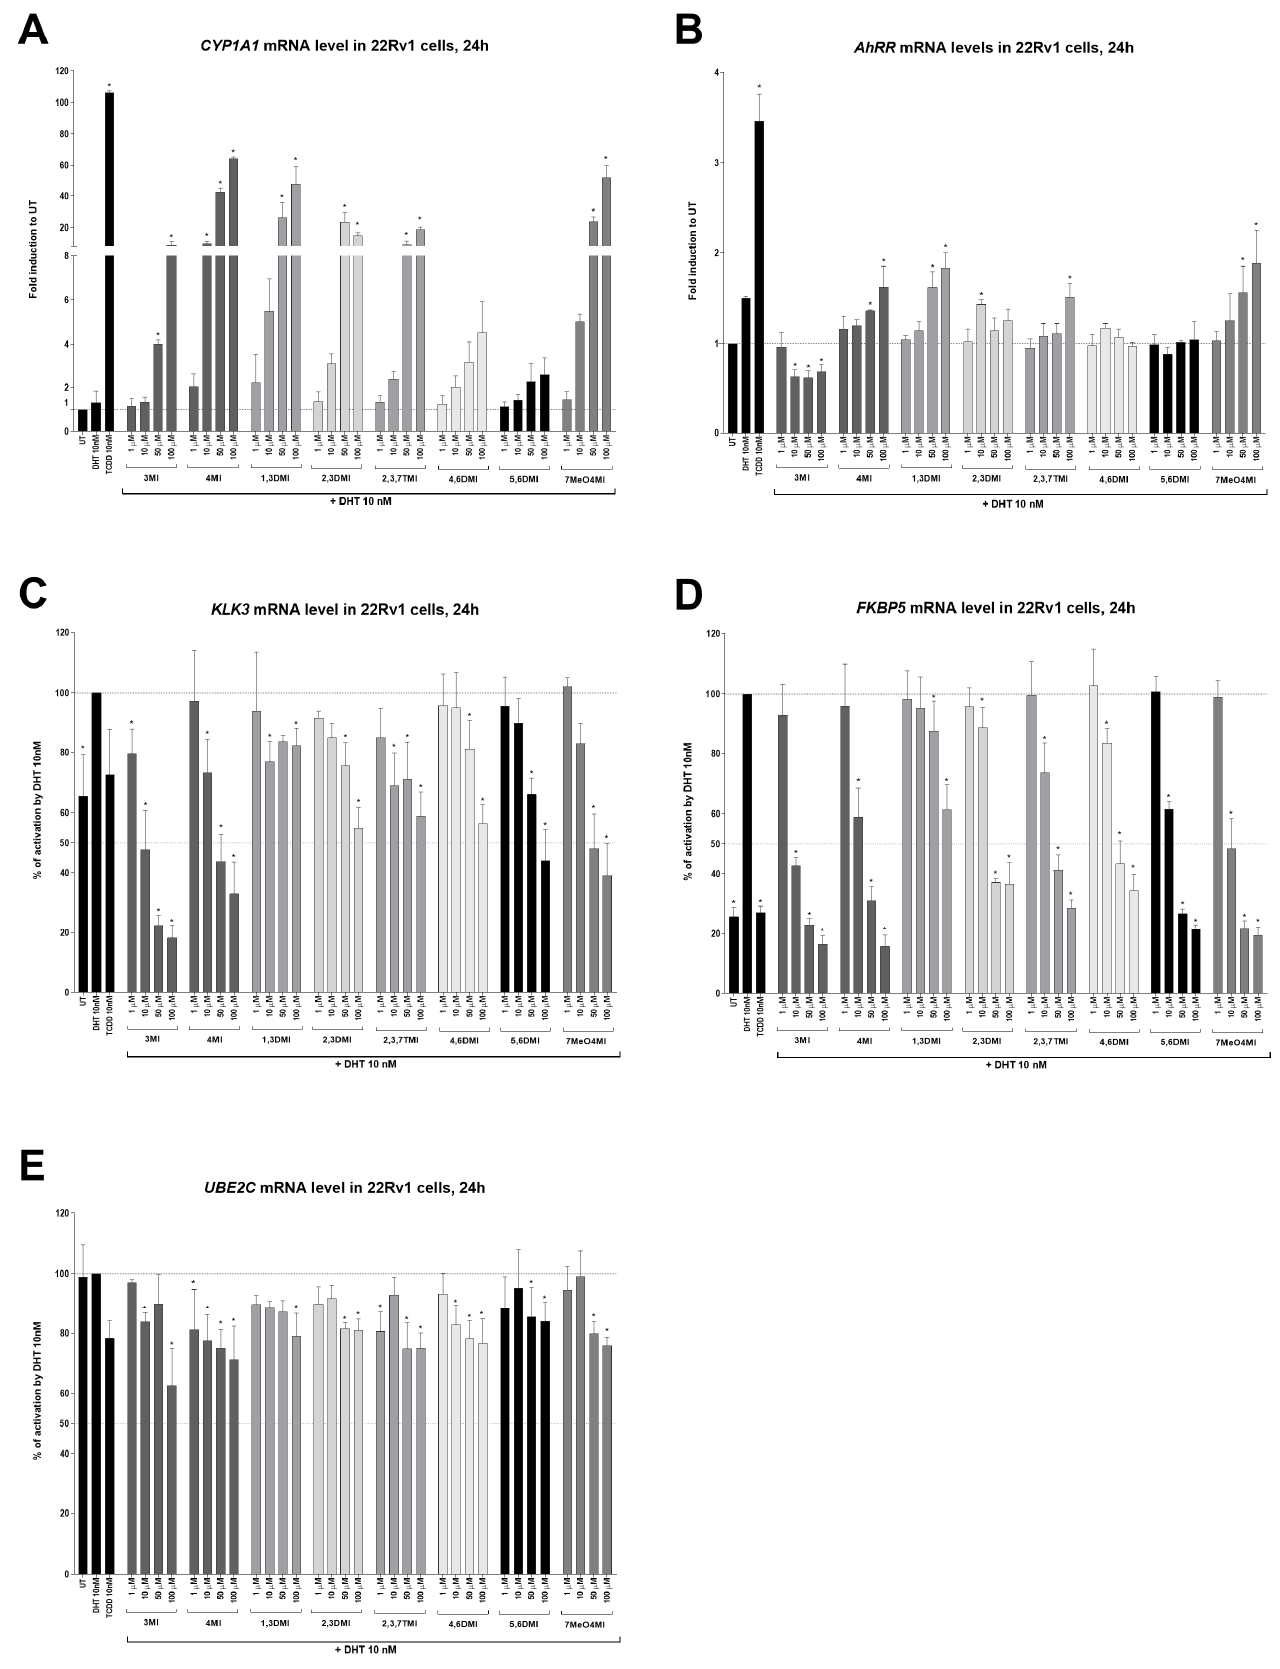
Figure 3. Effects of indoles on the expression of AhR- and AR-target genes. 22Rv1 cells were incubated with indoles (1 µM to 100 µM) in the presence of DHT 10 nM or controls (UT; DHT 10 nM; TCDD 10 nM) for 24 h. The induction of AhR-target genes CYP1A1 ( A ), AhRR ( B ) and AR-target genes KLK3 ( C ), FKPB5 ( D ), and UBE2C ( E ) were determined by RT-qPCR. The data obtained were normalized per the housekeeping gene GAPDH levels. The results are expressed as fold induction in untreated (UT; DMSO-treated) cells (for AhR-target genes) or as a percentage when DHT 10 nM